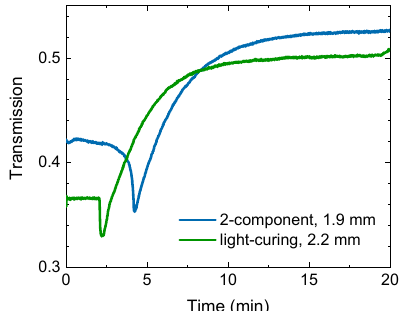
Figure 8. THz transmission through a 2-component and a light-curing adhesive during the curing process. Courtesy of TOPTICA Photonics AG.